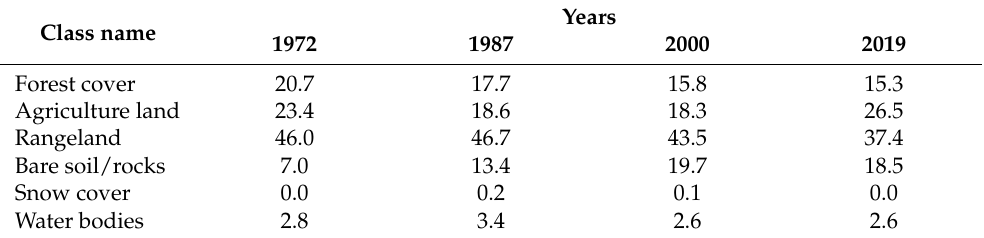
Table 10. Land use and land cover changes within 2 km of roads (%).